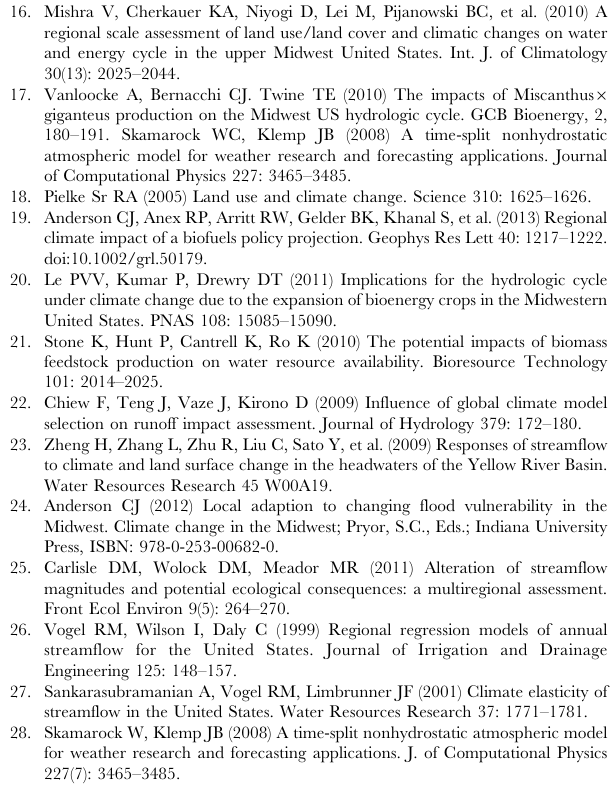
Figure S5 Change in mean annual runoff over 1981–2004 expressed in A) percentage change; B) absolute change (millime- ters). Figure S6 Change in streamflow volume when mean annual P and PET are varied by (A) adding and (B) subtracting a standard deviation of P and PET; (C) adding a standard deviation of elasticity ( e p and e pet ) estimates; and (D) subtracting a standard deviation of elasticity estimates among seven non-parametric approaches.